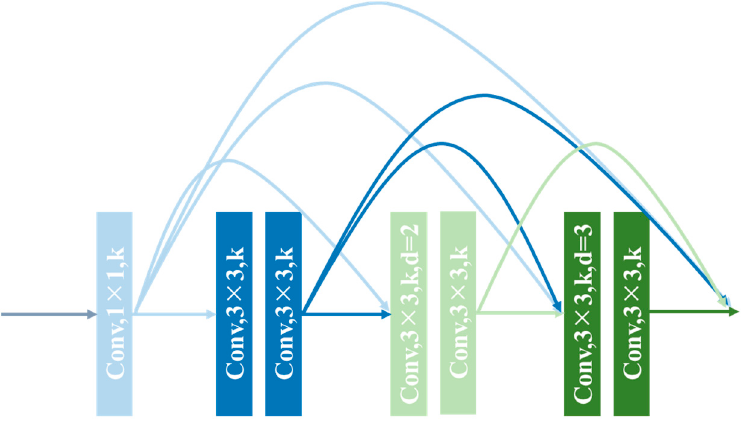
Figure 4 . Framework of the proposed dilated dense connection (DDC).